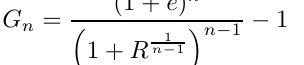
Fig. 7. Plot illustrating velocity gain as a function of the number of masses and the coefficient of restitution, for a vertically-stacked MVG chain with R = 0 . 012 . (-) means non-dimensional. mass can be maximized if the mass ratios obey the power law of Eq. (15), and it is given